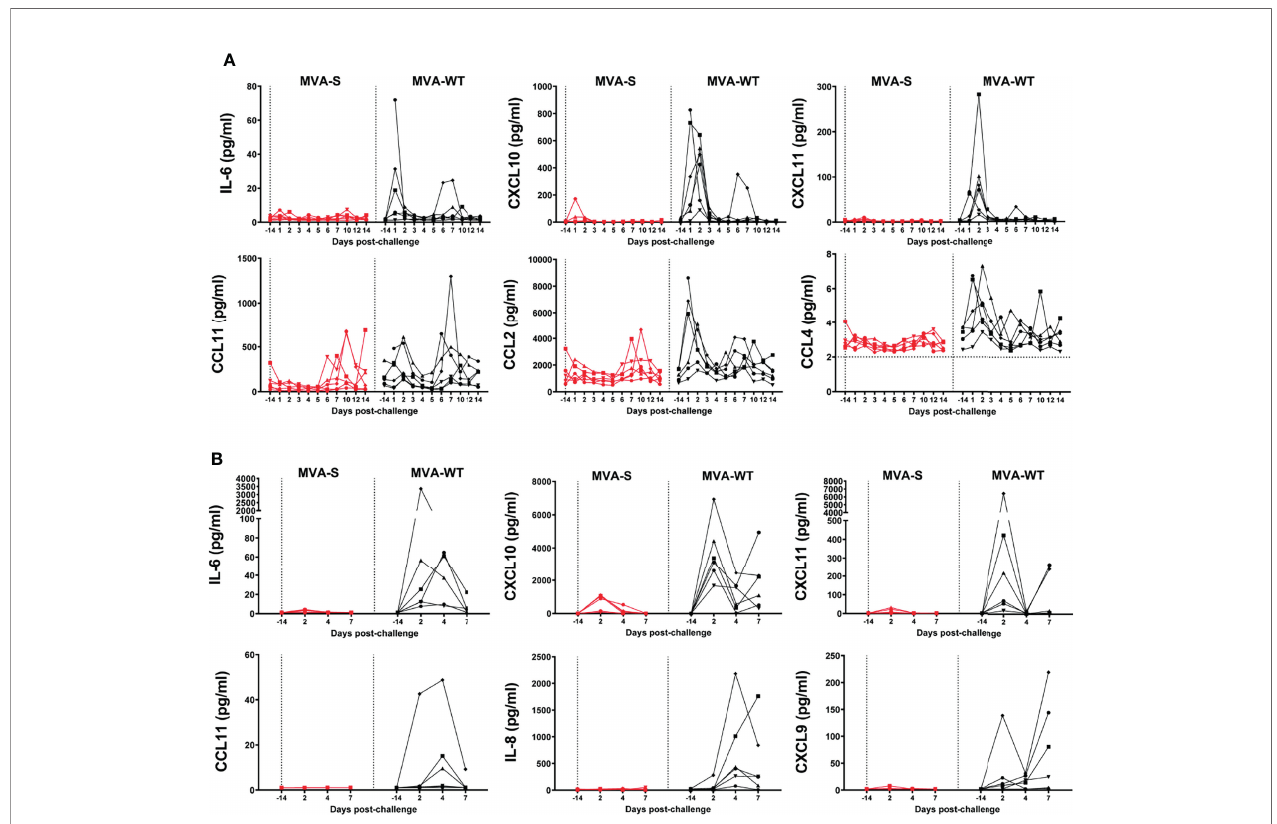
FIGURE 7 | Control of SARS-CoV-2-induced cytokine storm by MVA-S vaccine candidate. (A) IL-6, CXCL10, CXCL11, CCL11, CCL2, and CCL4 levels in serum of MVA-S (red) and MVA-WT (black) groups in time. Horizontal dotted line indicates lower limit of detection. At day -14, the sample of one MVA-WT animal is missing. (B) IL-6, CXCL10, CXCL11, CCL11, IL-8, and CXCL9 levels in BAL of MVA-S (red) and MVA-WT (black) groups in time. All data are shown relative to the day of challenge (day 0, study day 56). Levels of individual values (indicated by different symbols) in time are shown. No measurements were performed on day of challenge, but data obtained at day 14 before challenge are